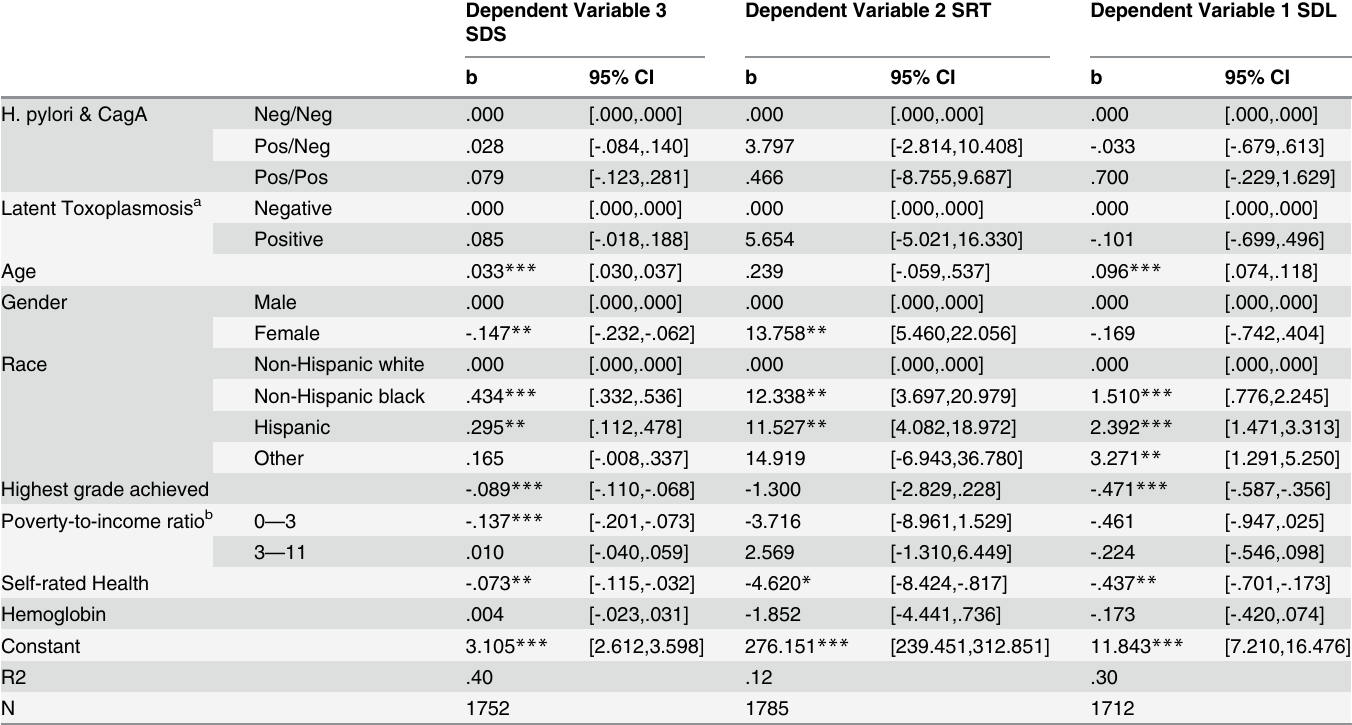
Table 2. Analysis of Three Measures of Cognitive Functioning in US 21 to 59 Year-Olds, NHANES III (1988 – 1994): Unstandardized Coef fi cients from Weighted OLS Regression.